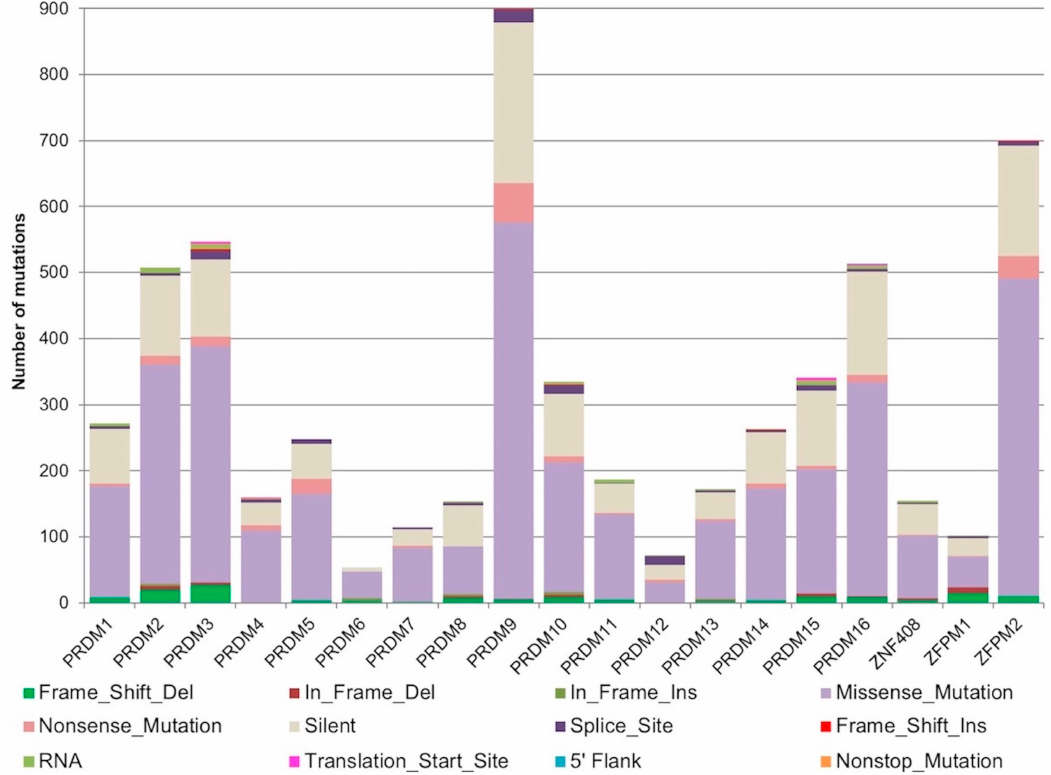
Figure 1. Stacked histograms showing the number of different classes of somatic mutations affecting PRDM genes as reported in the Mutation Annotation Files across all analyzed cancer